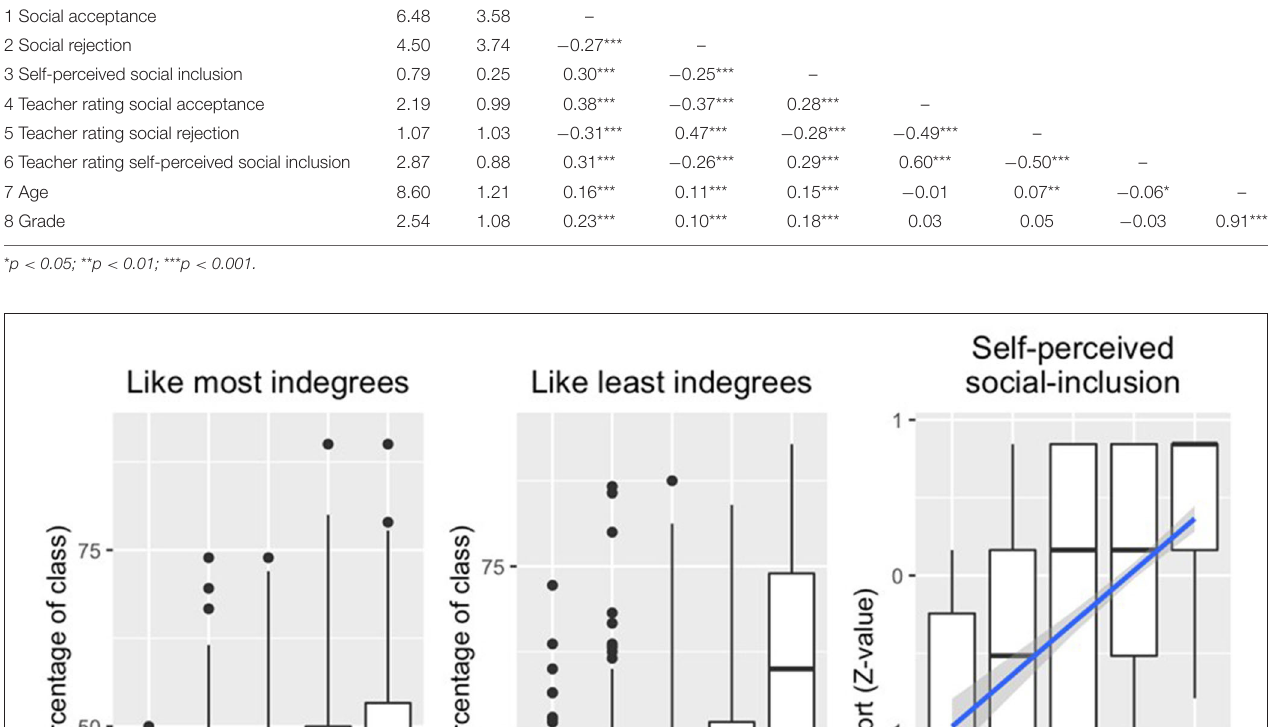
0.001), indicating a weak concordance here. The variability was very high for all three criteria (minima between r = −